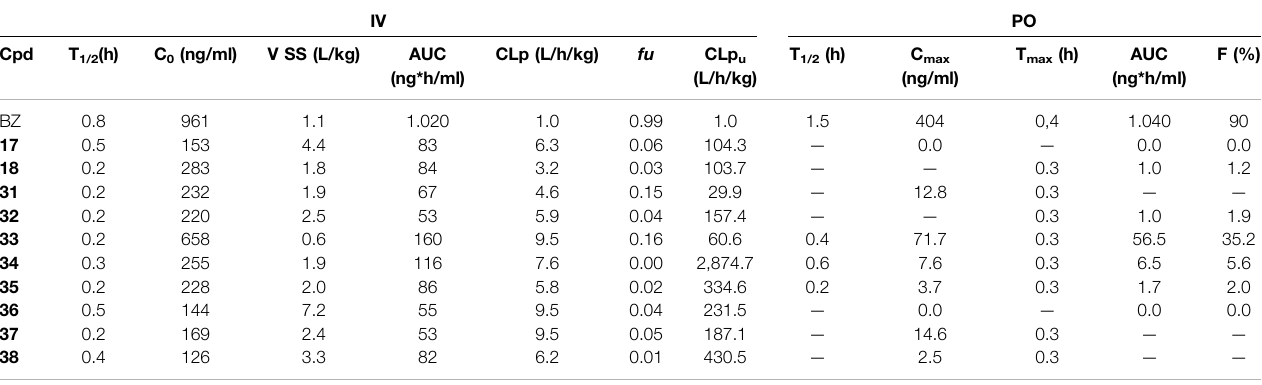
TABLE 6 | In vivo PK pro fi les of selected benzimidazole